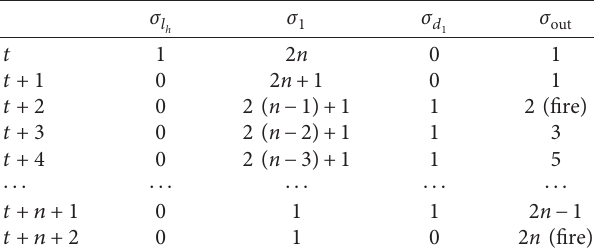
Figure 5: Module OUTPUT. Table 2: The results of module